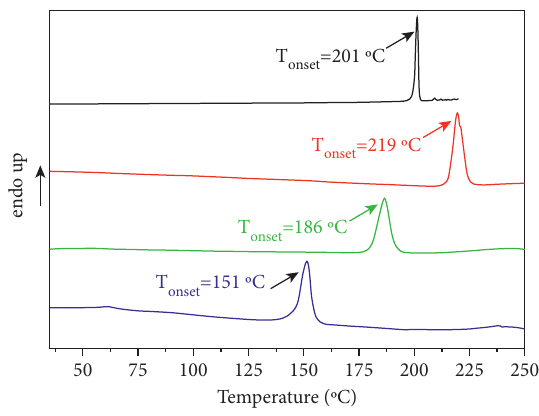
Figure 9: IR spectra of FEB (black), FEB-BIP cocrystal (red), FEB- 3AP salt (green), and FEB-4HP-H2O salt (blue).